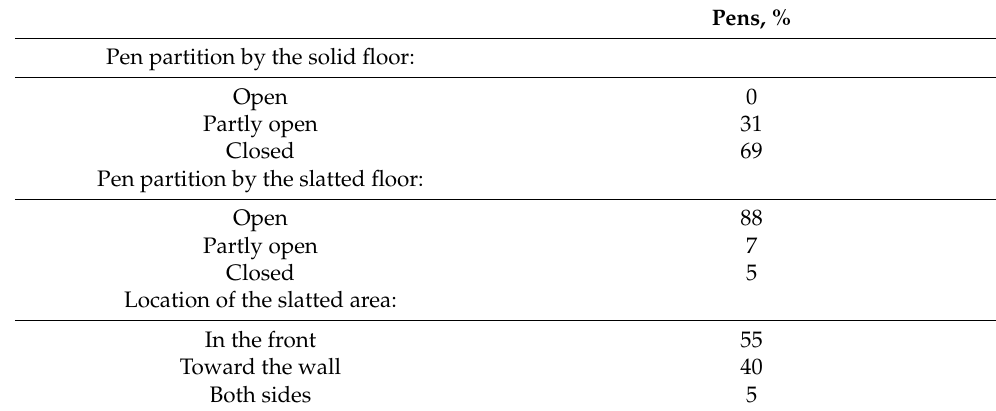
Table 3. Descriptive data for pen design.